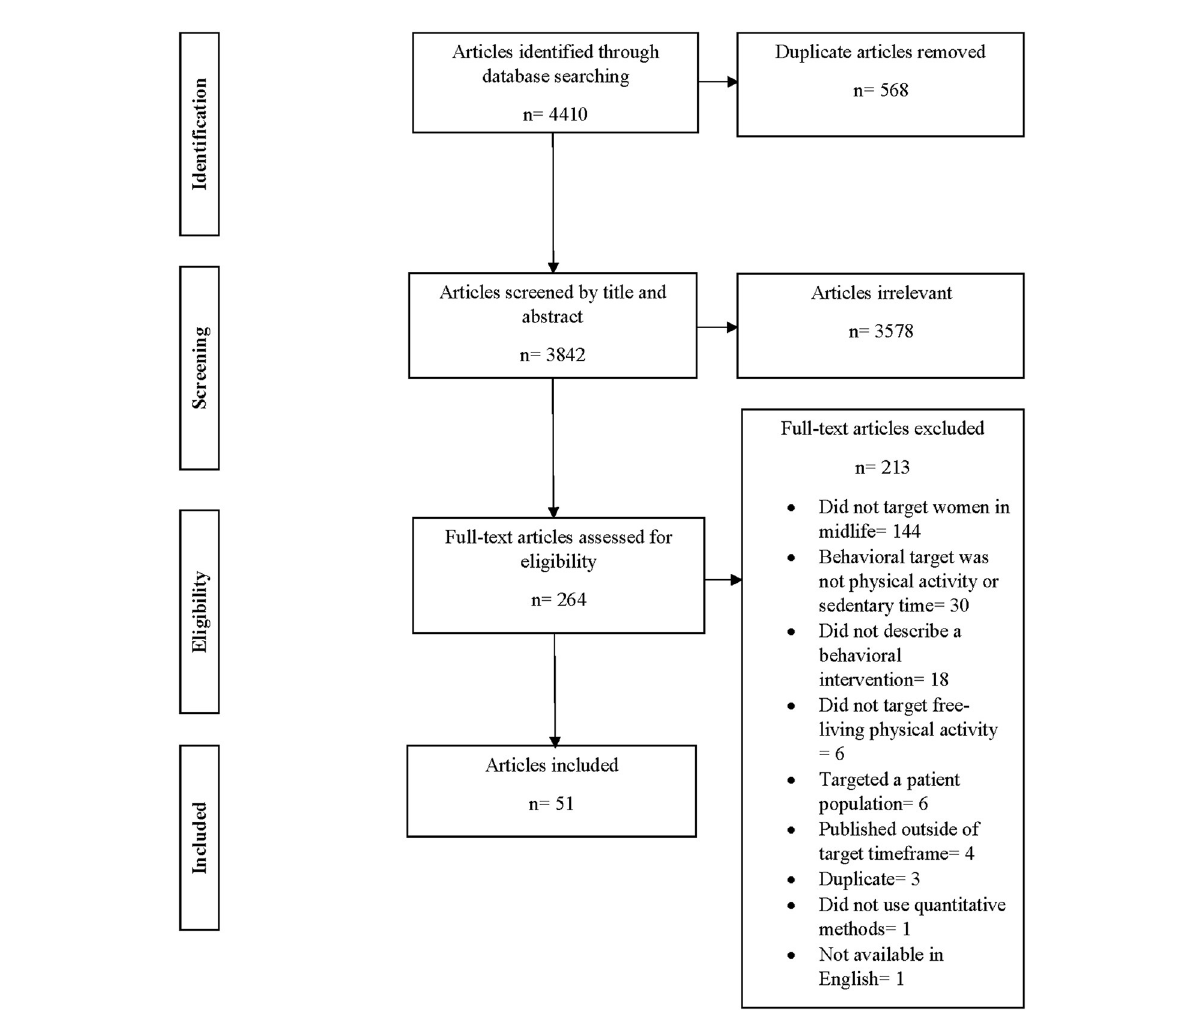
FIGURE1 PRISMA flowchart of selection, sorting, and data